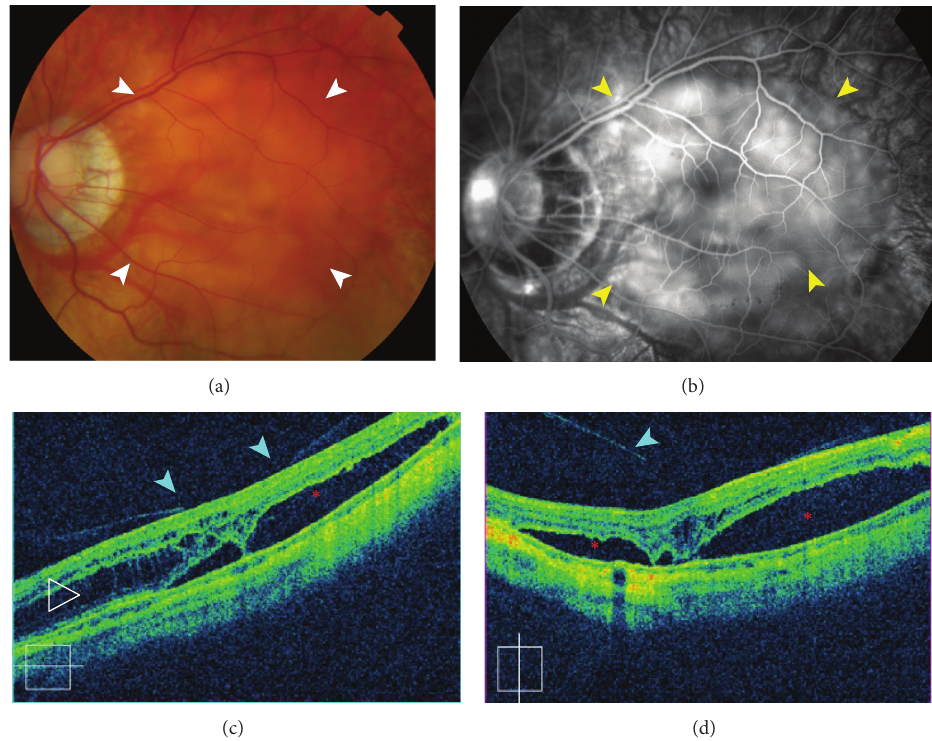
Figure 1: Color retinography, fluorescence angiography, and optical coherence tomography at the initial visit. (a) Left fundus photography showing a shallow retinal elevation between the temporal vascular arcades (white arrow) with peripapillary diffuse chorioretinal atrophy and a vertically elongated optic disc. (b) Late-phase fluorescein angiography image depicting irregular and diffuse hyperfluorescence at the posterior pole (yellow arrow). (c and d) Horizontal and vertical spectral-domain optical coherence tomography revealed the presence of myopic foveoschisis (open arrowheads) with a foveal retinal detachment (red asterisk) and a partially detached posterior hyaloid (blue